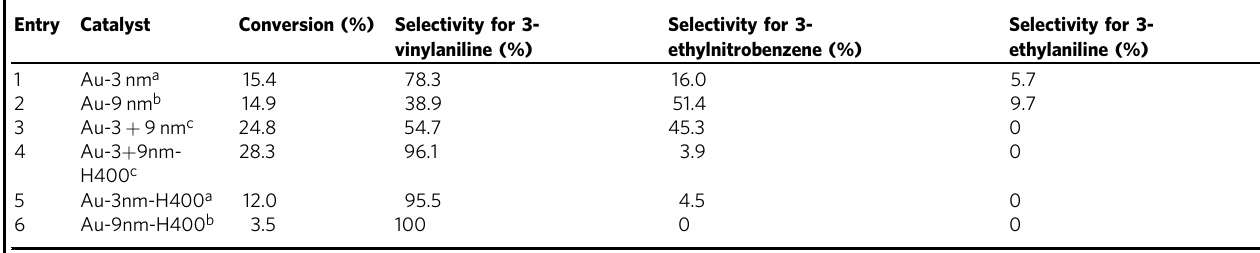
Table 1 Chemoselective hydrogenation of 3-nitrostyrene using different catalysts. Entry Catalyst Conversion (%) Selectivity for 3-